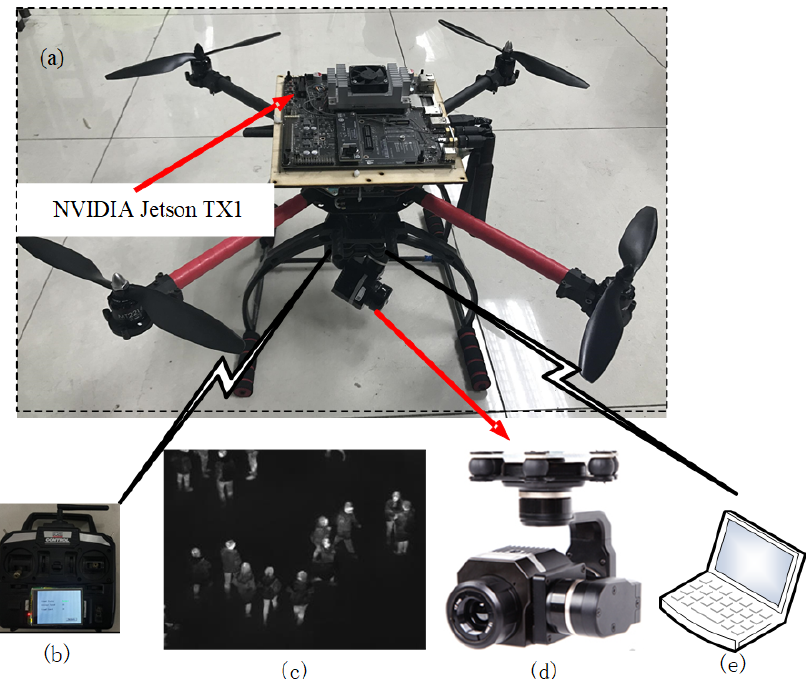
Figure 1. Schematic diagram of monitoring unmanned aerial vehicles (UAV). ( a ) UAV with an infrared camera; ( b ) remote control; ( c ) representative image in our new infrared-based abnormal crowd behavior dataset; ( d ) FLIR TAU2-336 infrared thermal imager; ( e ) ground control station.